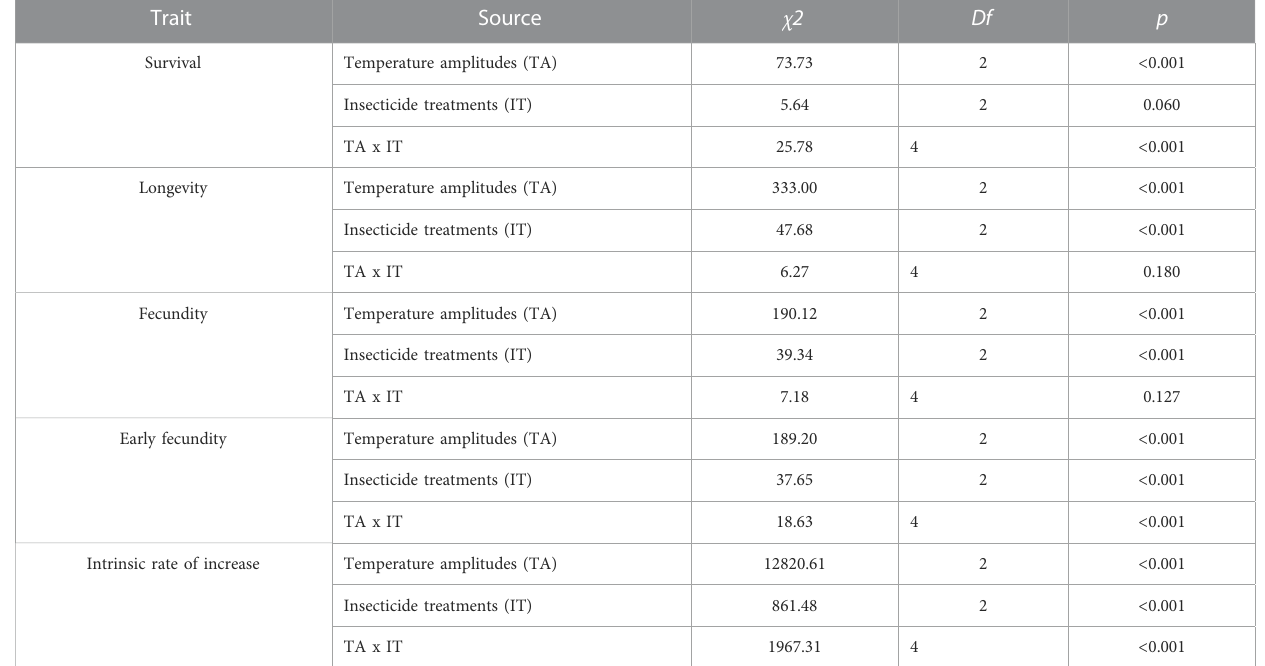
TABLE 1 Results of the temperature amplitude and insecticide effects on Sitobion avenae .